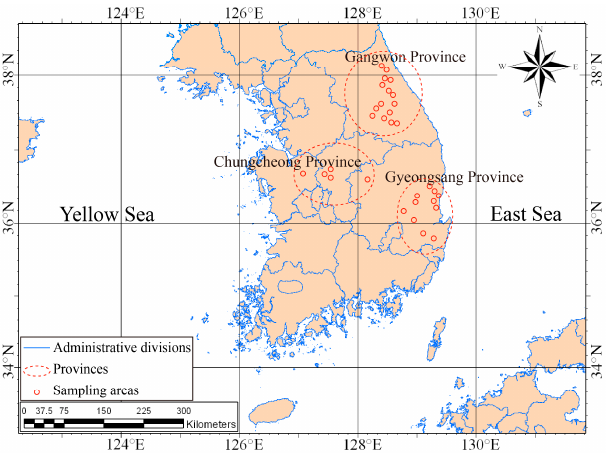
Figure 1. Sampling regions of carbonated water in South Korea [13].